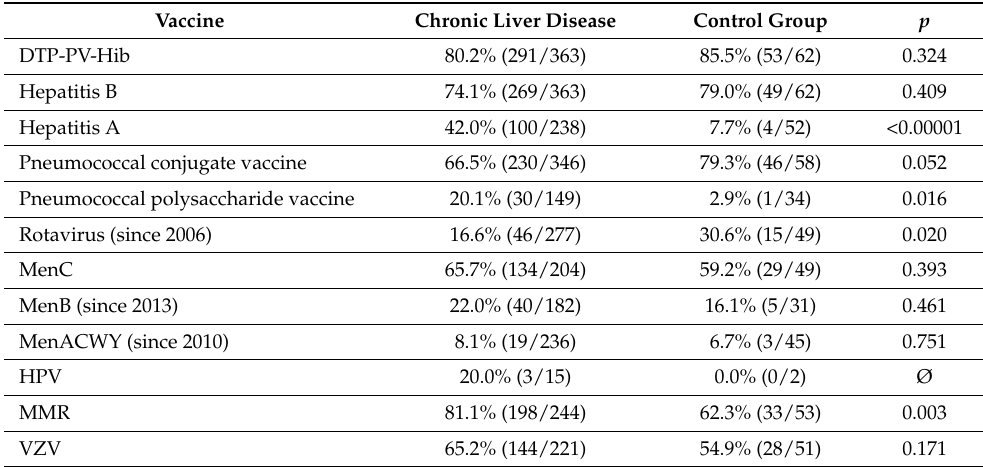
Table 2. Age-appropriate vaccination in children with chronic and acute liver disease. Data expressed as percentage of age-appropriate vaccination (number of age-appropriate vaccinated children/total number of eligible children).